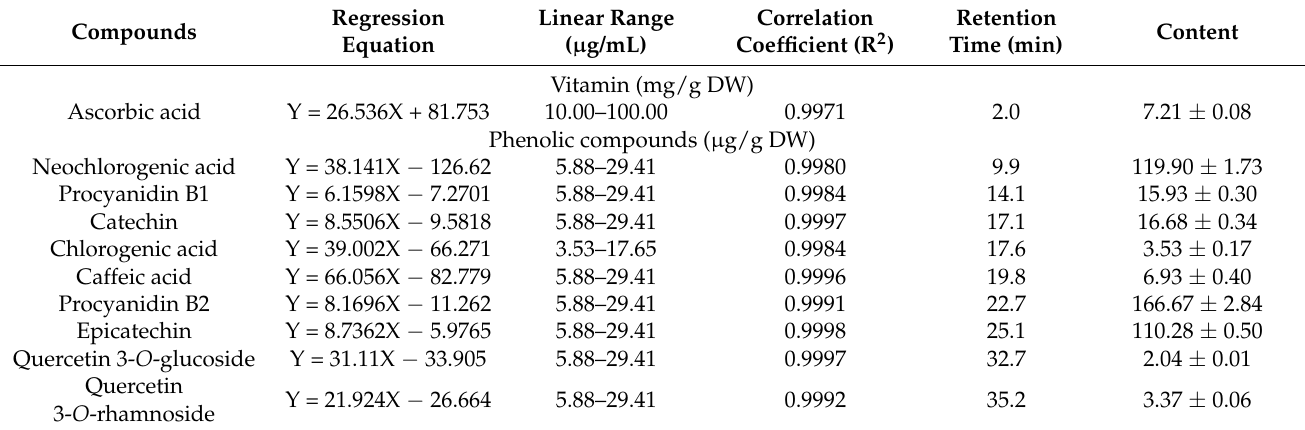
Table 6. The contents of vitamin C and major phenolic